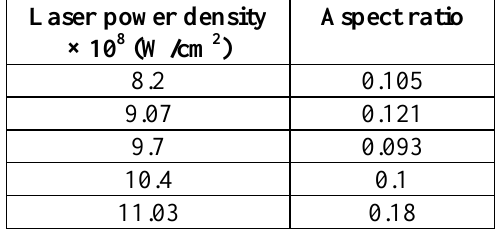
Table 1: Aspect ratio of drilled holes depth in aluminum at variable laser power